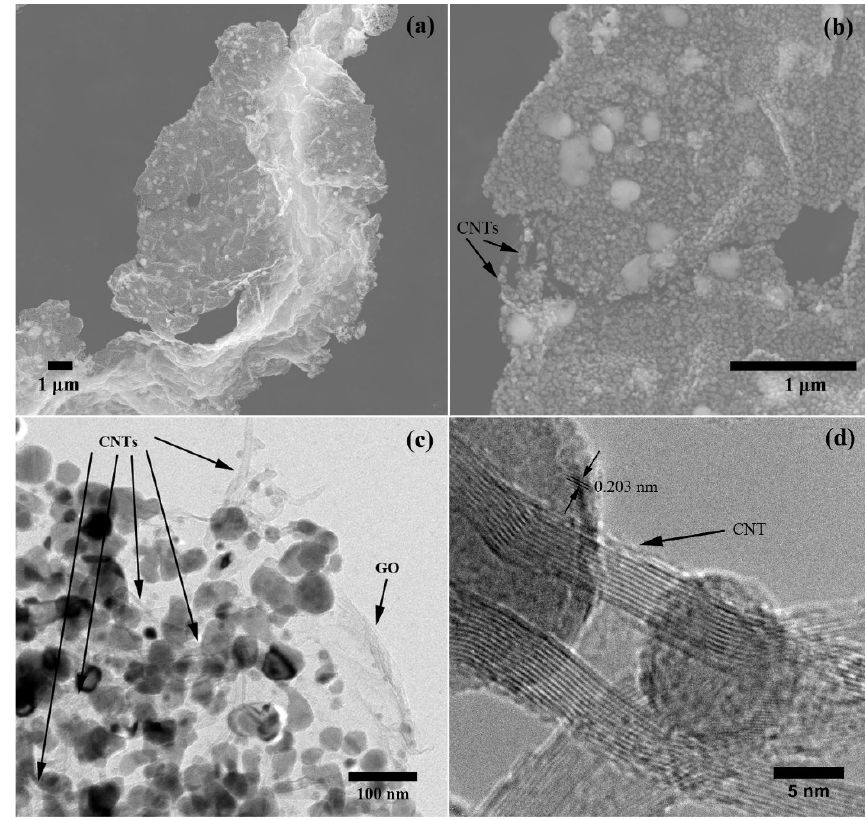
Figure 3. SEM ( a , b ) and TEM images ( c , d ) of NiGNT